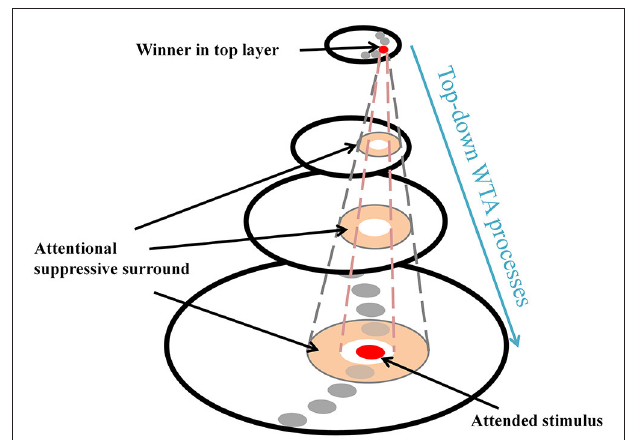
FIGURE 1 | Schematic attentional selection as suggested by the Selective Tuning model. When a signal from an attended stimulus reaches the top layer, a top-down winner-take-all (WTA) mechanism localizes this stimulus. During this process, the mechanism inhibits irrelevant connections that surround the attended stimulus, thus, attentional surround suppression occurs (adapted from Hopf et al., 2006 with